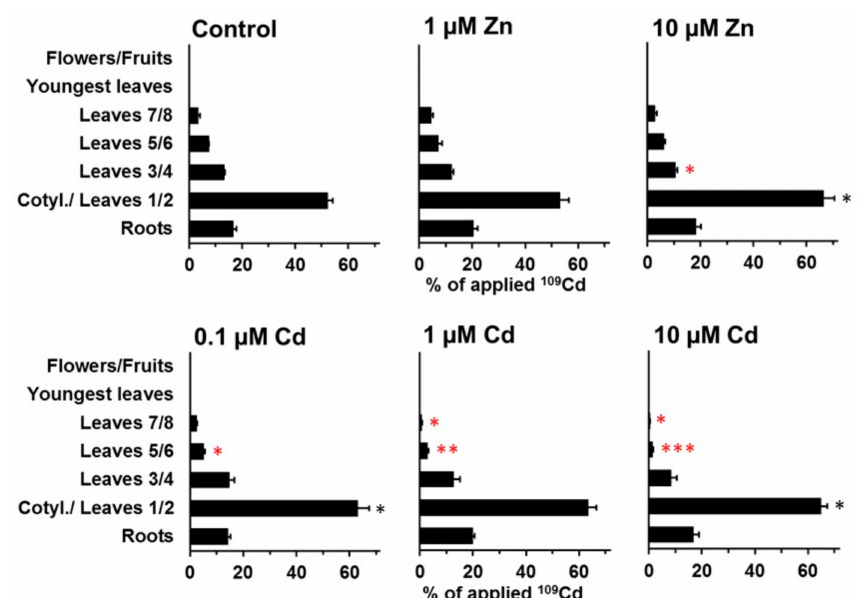
Figure 5. Redistribution of 109 Cd in plants grown on standard nutrient medium (Control) or on the same medium with increased Zn (1 µM Zn and 10 µM Zn) or Cd (0.1 µM Cd, 1 µM Cd, and 10 µM Cd) concentrations for 11 d after the labeling phase (duration: 3 d). Means + SE of four replicates are shown. Significantly higher (*, **, ***) and lower (*, **, ***) values than in control plants on the P=0.05 (*, *), P=0.01 (**, **) and P=0.001 (***, ***) level are indicated (Student’s t-test).